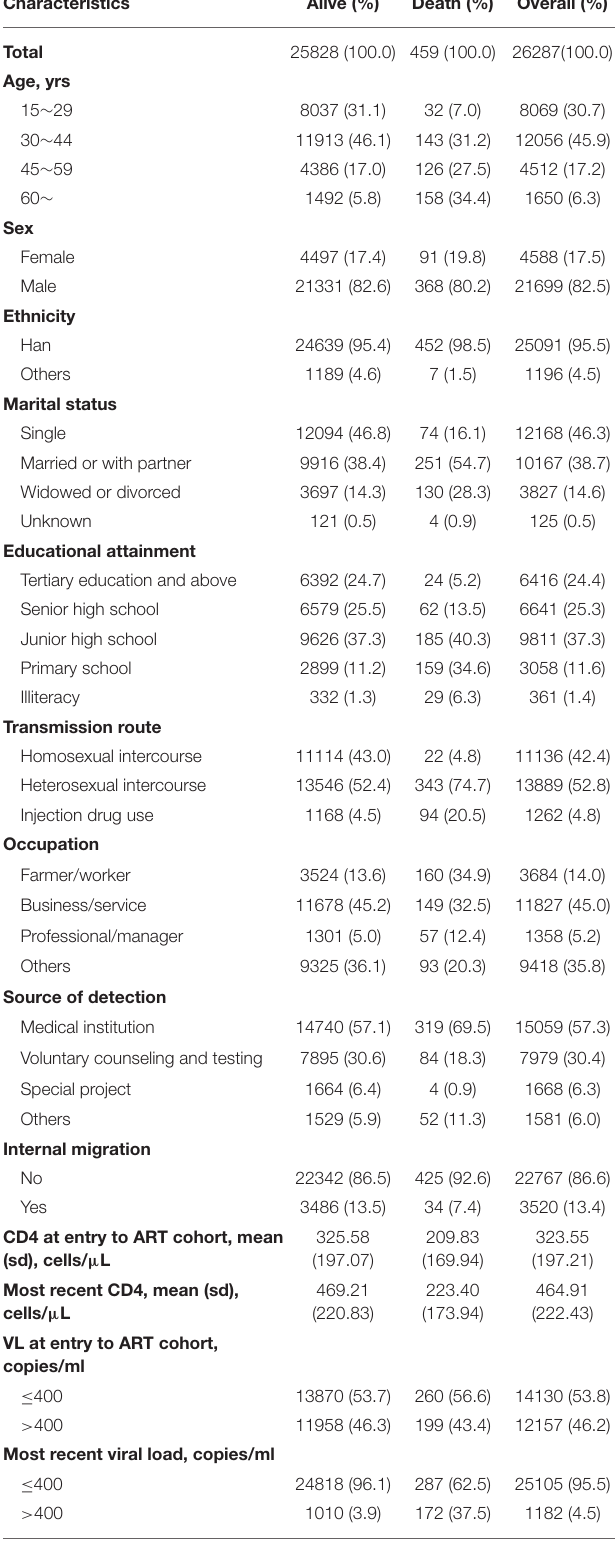
TABLE 2 | Characteristics of people living with HIV recruited in the ART cohort.